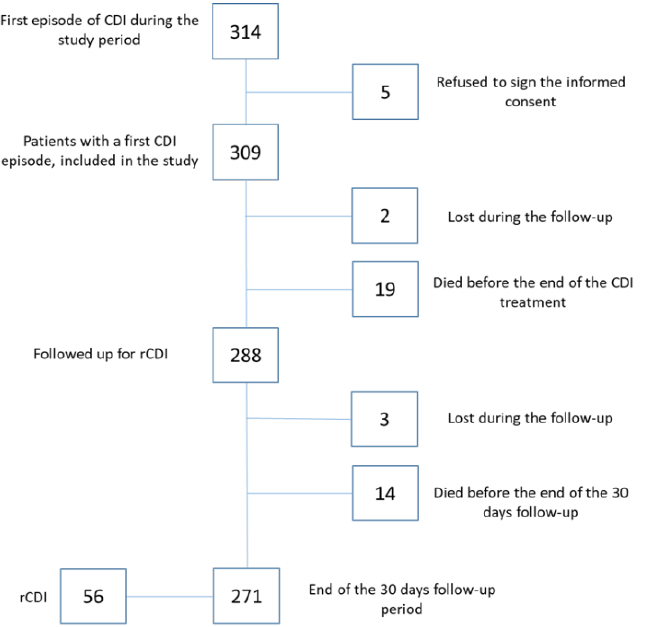
Figure 3. Follow-up of patients included in the study. CDI : Clostridioides difficile infection; rCDI: recurrent Clostridioides difficile